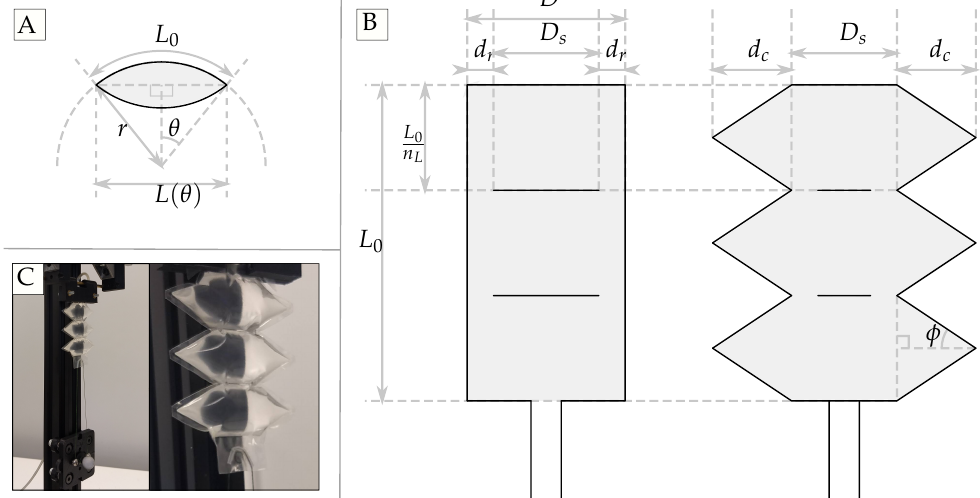
Figure 1. Key dimensions of a single actuator chamber. ( A ) Cross section of a partially contracted actuator. ( B ) Dimensions of a typical rectangular Pouch Motor (left) and our actuator design (right). ( C ) Images of actuator in a test